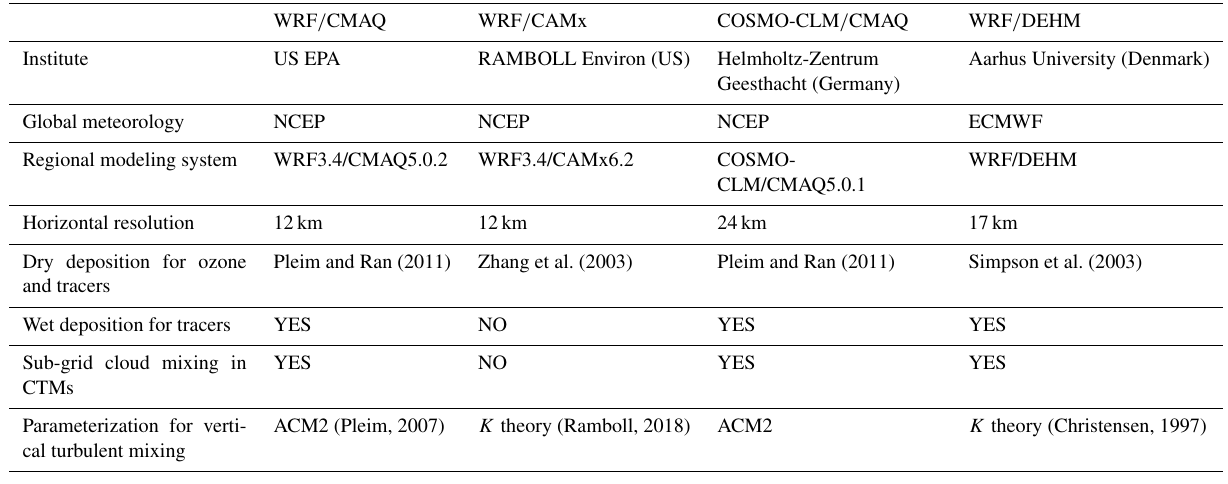
Table 1. Model description of the four simulations involved in the study.